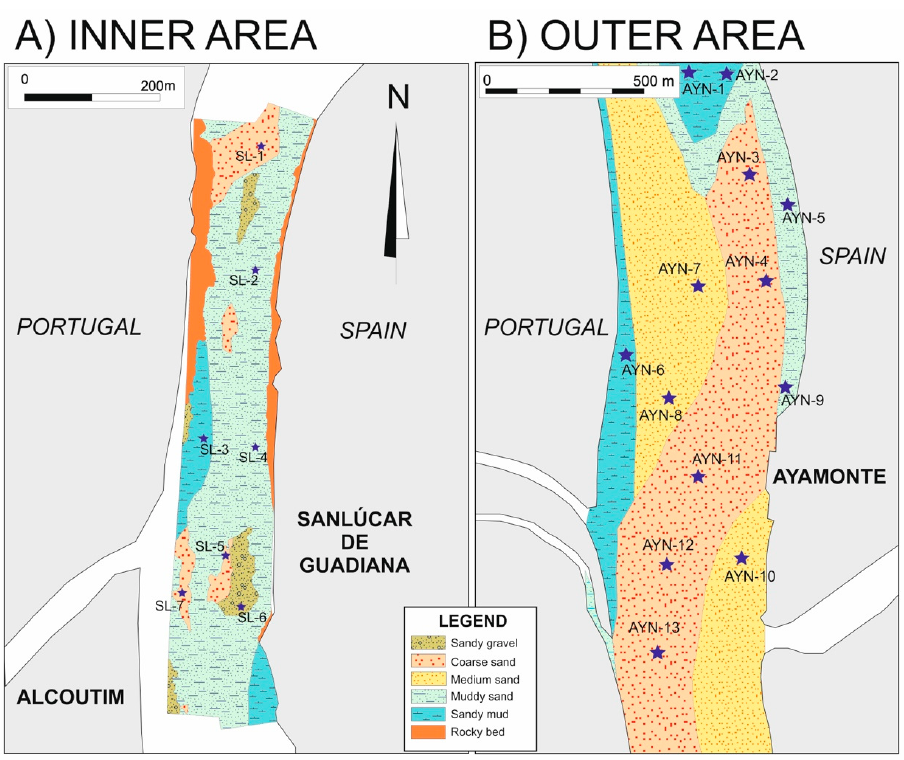
Figure 5. Distribution of the sediment types in the two studied areas. ( A ) Stars mark the location of the sediment samples. Sampling key: SL = Sanlucar (inner area); ( B ) AYN = Ayamonte North (outer area).